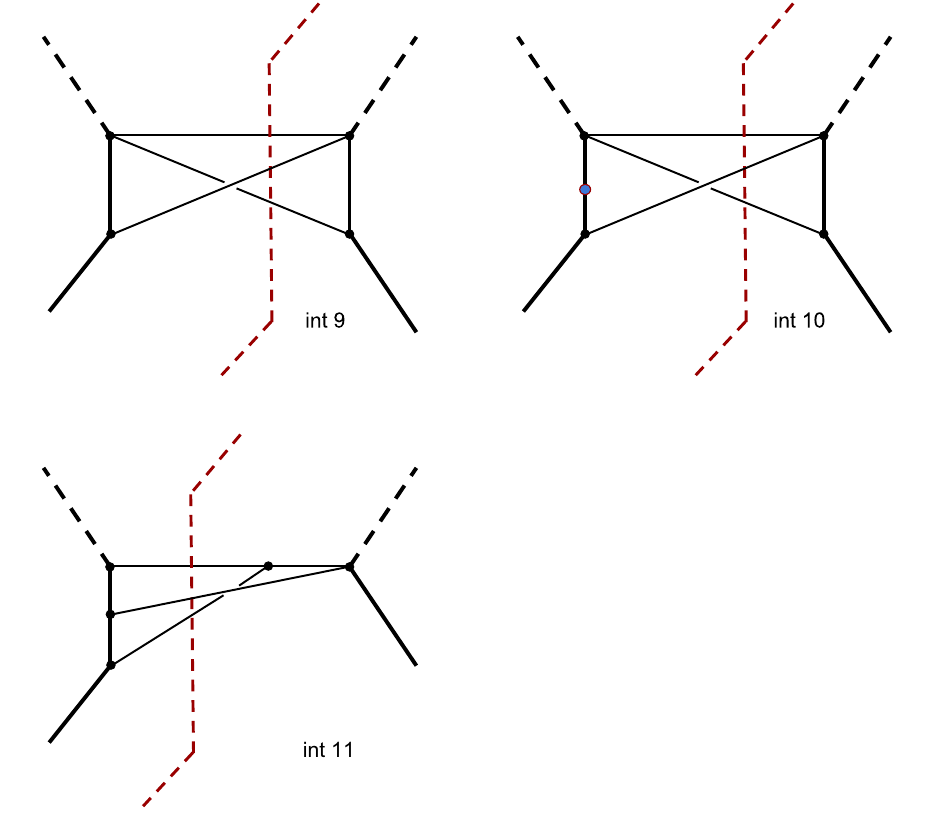
Fig. 3 Additional master integrals from Topology B; integrals I 9 , I 10 , I 11